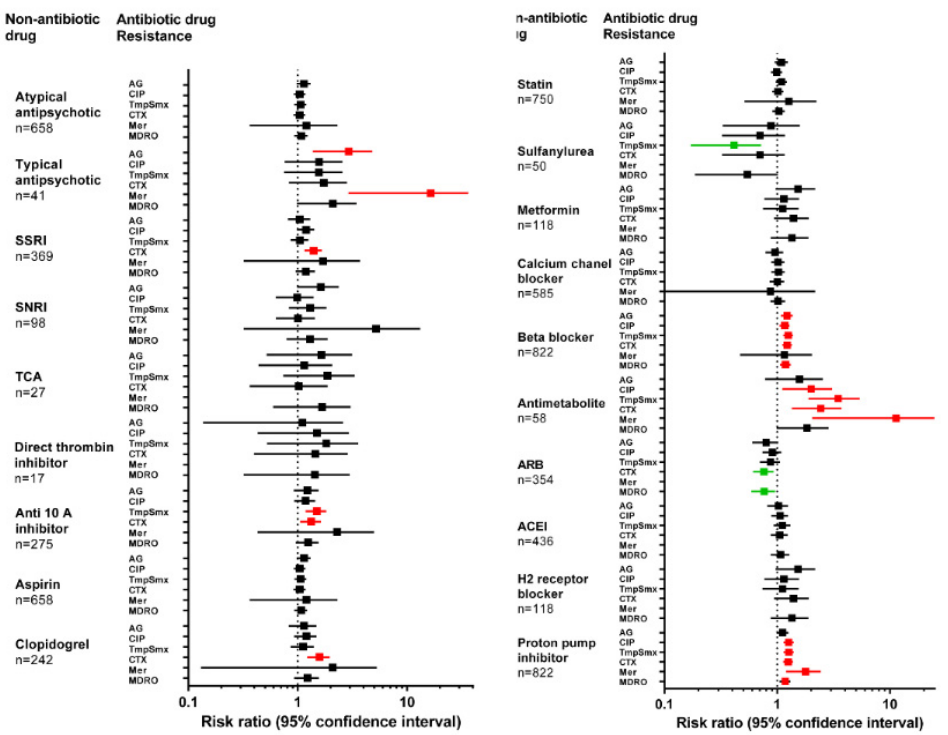
Figure 1. Risk of antimicrobial resistance and non-antimicrobial drug exposure. The forest plot shows the risk of infection with a drug-resistant organism expressing each of 5 resistance phenotypes, as a function of recent exposure to non-antimicrobials. Squares represent odds ratio, and whiskers represent the 95% confidence interval. Markers in red and green represent significantly increased or decreased risk of resistance phenotype, respectively. AG: aminoglycoside; CIP: ciprofloxacin; Tmp-Smx: trimethoprim-sulfamethoxazole; CTX: ceftriaxone; Mer: meropenem; MDRO: multidrug resistant organism; SSRI: selective serotonin reuptake inhibitor; SNRI: serotonin and norepinephrine reuptake inhibitor; TCA: tricyclic antidepressant; ARB: angiotensin receptor blocker; ACEI: angiotensin converting enzyme inhibitor. Table 3. Patient variables associated with non-antimicrobial drug